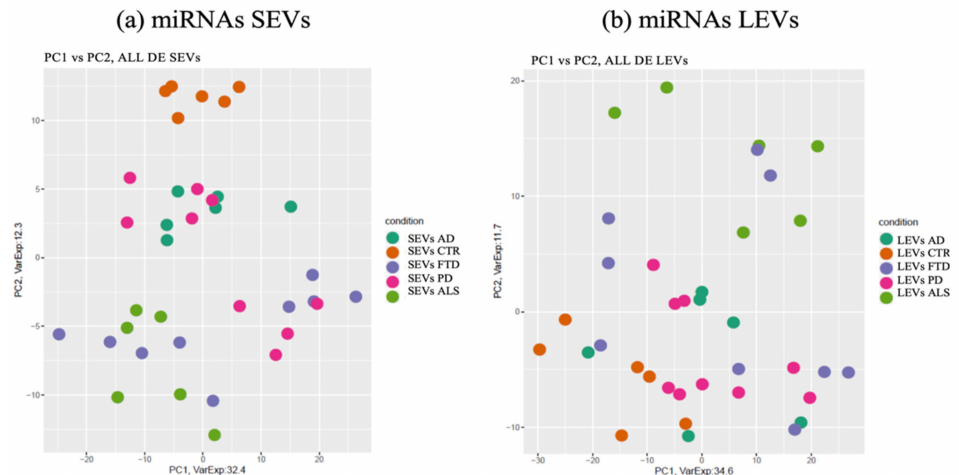
Figure 2. Principal component Analysis (PCA) of miRNAs differentially expressed in SEVs ( a ) and LEVs ( b ) of ALS, FTD, AD and PD patients and healthy controls (CTRs). PCA is performed using as predictors all the miRNAs identified as differentially expressed in at least one disease in the comparison of each disease to the control state. Each dot represents a sample and each color represents a disease. AD = Alzheimer Disease; FTD = Fronto-Temporal Dementia; ALS = Amyotrophic Lateral Sclerosis; PD = Parkinson Disease; CTRs = controls; SEVs = small extracellular vesicles; LEVs = large extracellular vesicles; miRNA =